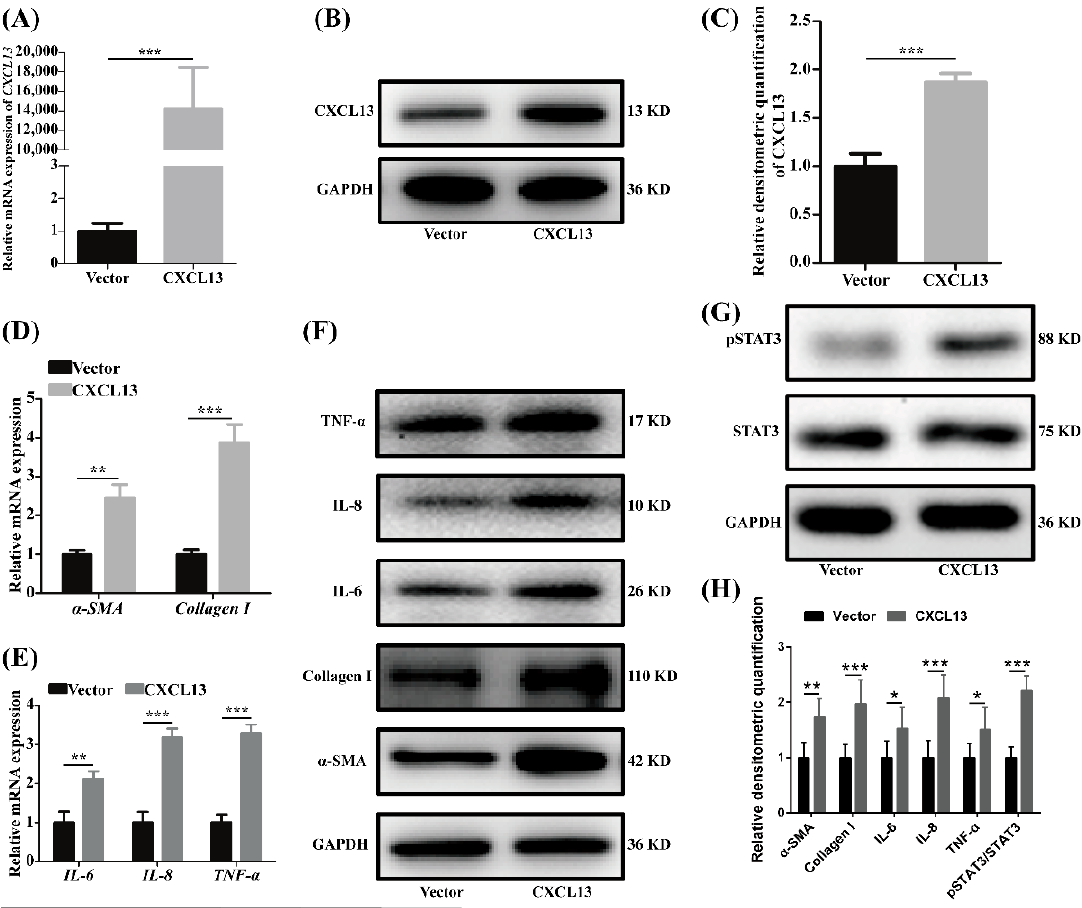
Figure 4. Overexpression of CXCL13 promoted inflammation and fibrosis of WPMY-1 cells through STAT3 pathway. ( A – C ) Overexpression efficiency of CXCL13 at the mRNA and protein levels. ( D – F ) The mRNA and protein level of fibrosis and inflammation markers after CXCL13 overexpression. ( G ) The protein level of STAT3 pathway after CXCL13 overexpression. ( H ) Relative densitometric quantification of fibrosis-, inflammation- and pathway-related proteins. * p < 0.05, ** p < 0.01 and *** p < 0.001.